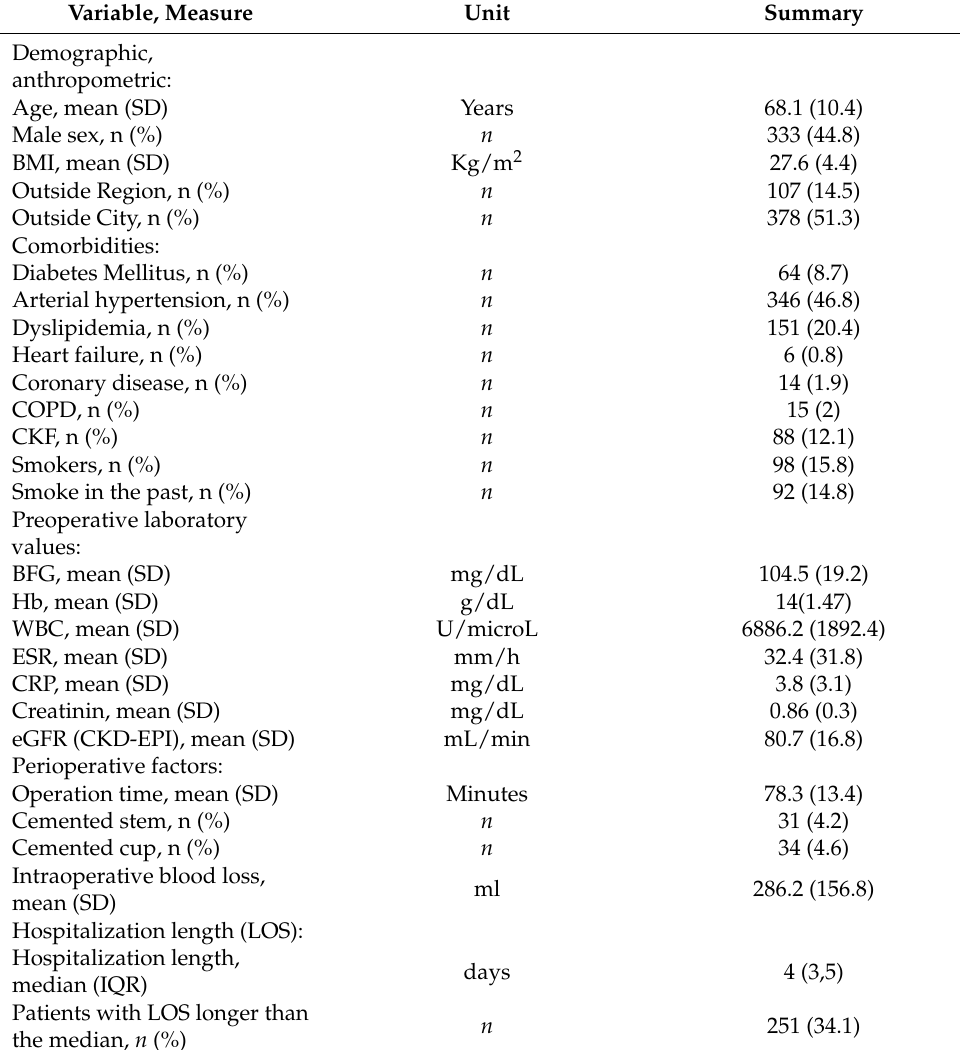
Table 1. Descriptive statistics of study variables.